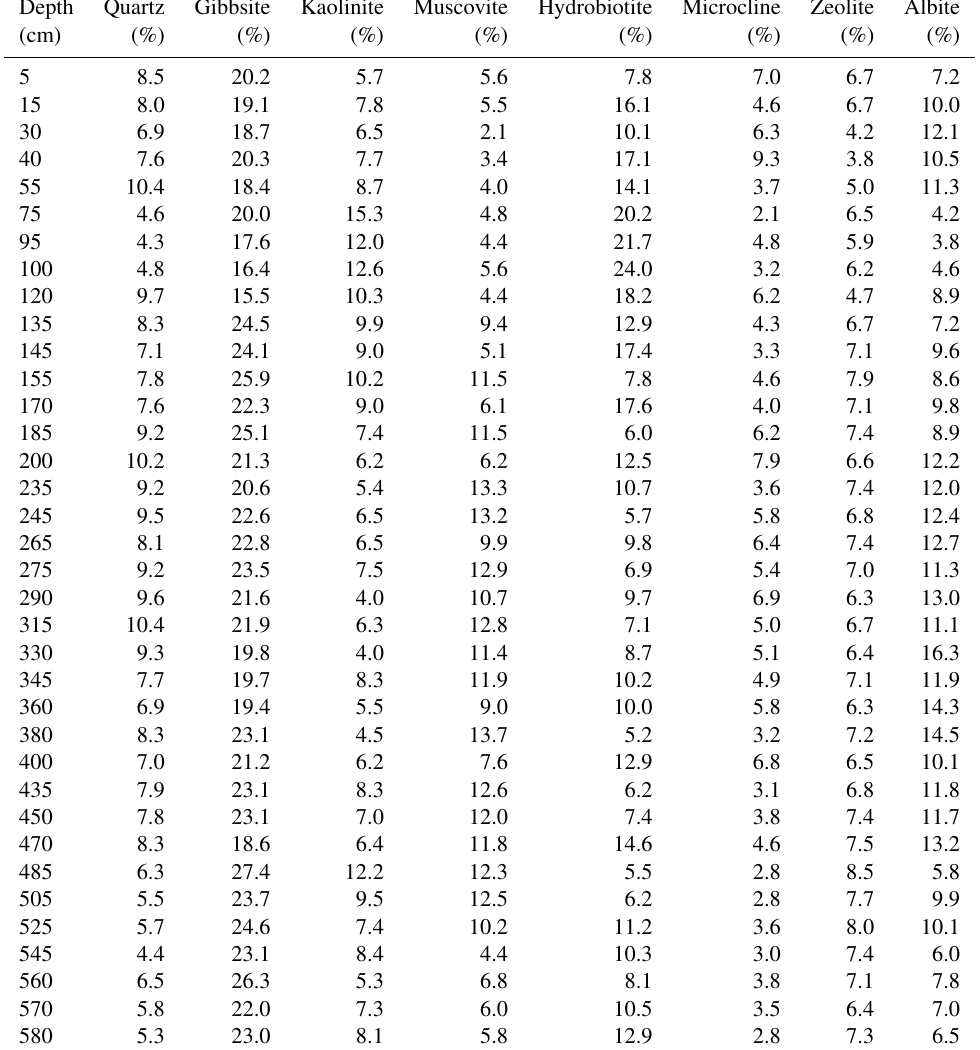
Table A1. Major noncarbonaceous mineral phases in core M125-34-2 derived from Rietveld analyses of X-ray diffractometry.